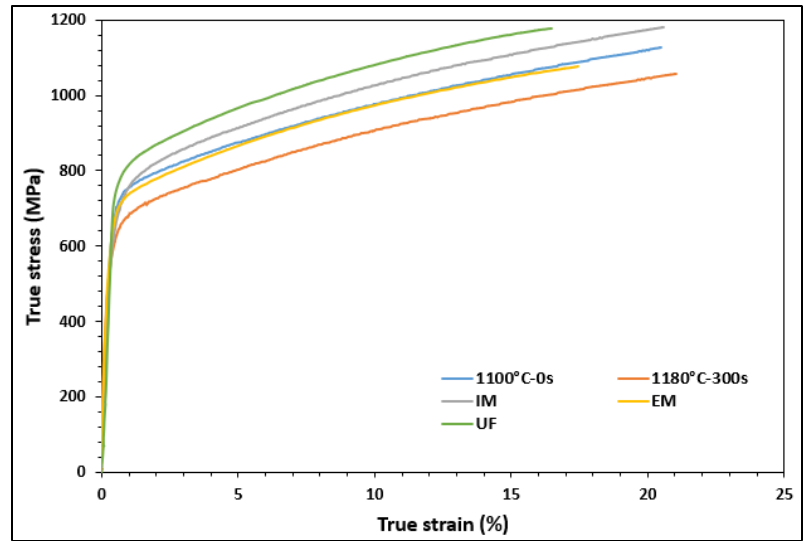
Figure 12. Tensile true stress – strain curves for all microstructures of superduplex stainless steel. Table 3. Tensile mechanical properties for all microstructures of superduplex stainless steel 2507. σ YS : Offset yield stress; σ UTS : Ultimate tensile stress; ε : Uniform